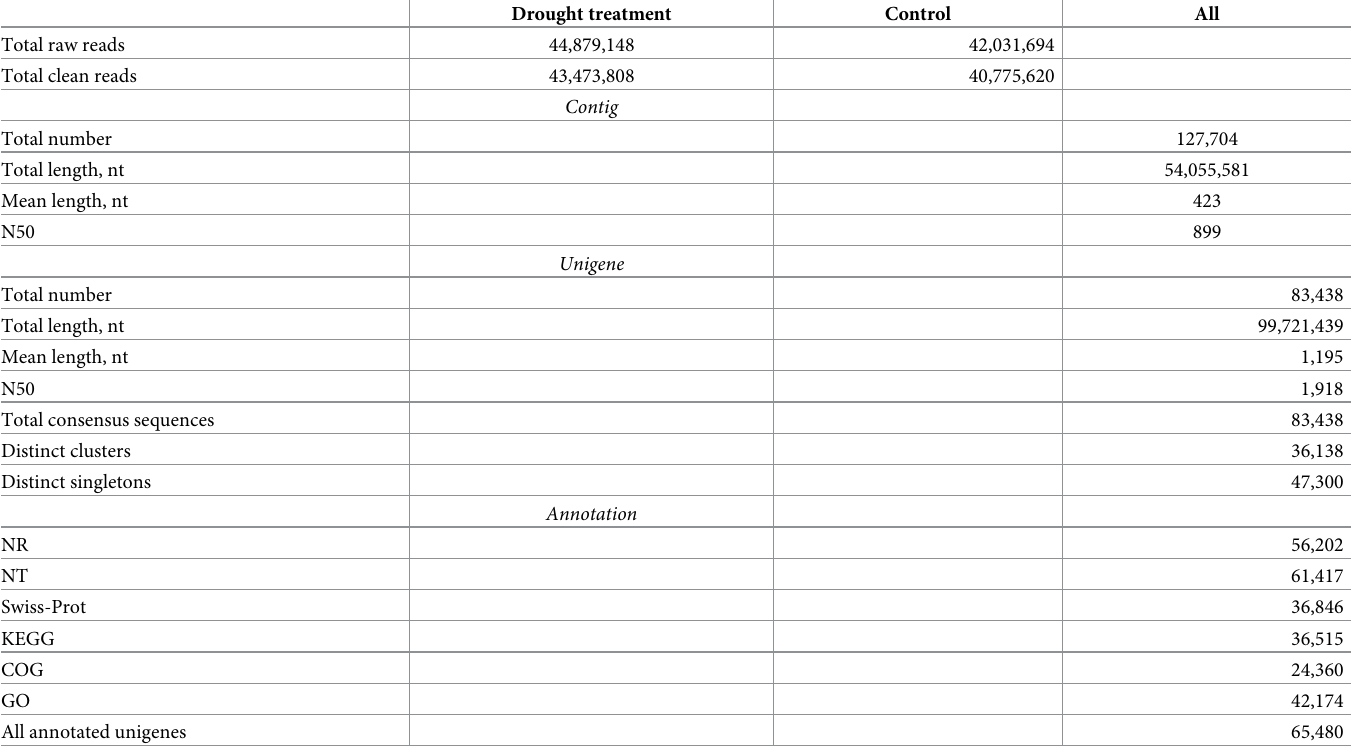
Table 1. Summary of RNA sequencing of the Coix lacryma-jobi L. Drought treatment Control